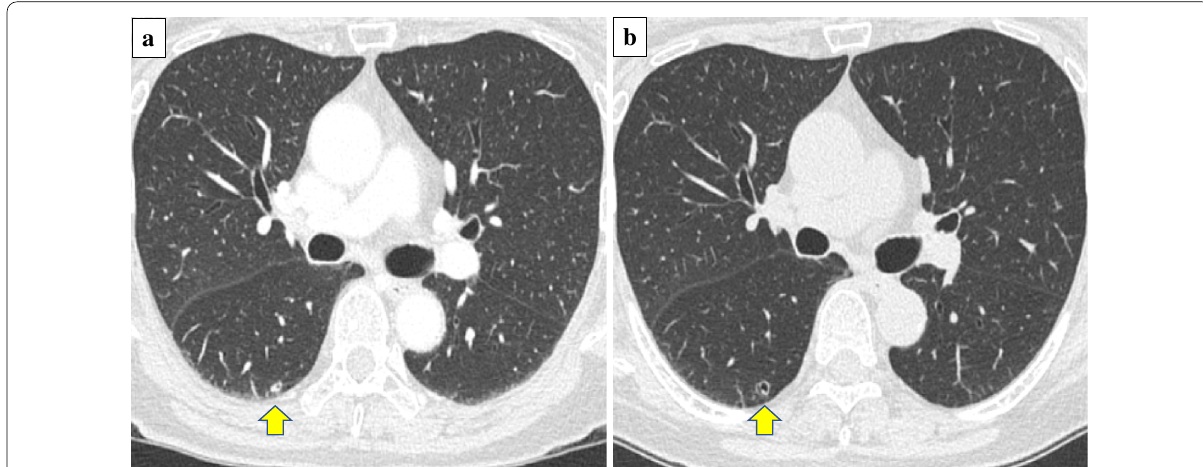
Fig. 1 Serial CT findings of a ciliated muconodular papillary tumor (CMPT) at a colectomy performed 14 months prior and b thoracoscopic surgery. Yellow arrows indicate tumor growth from the nodule to a cavitary lesion suspicious of metastasis of colorectal cancer